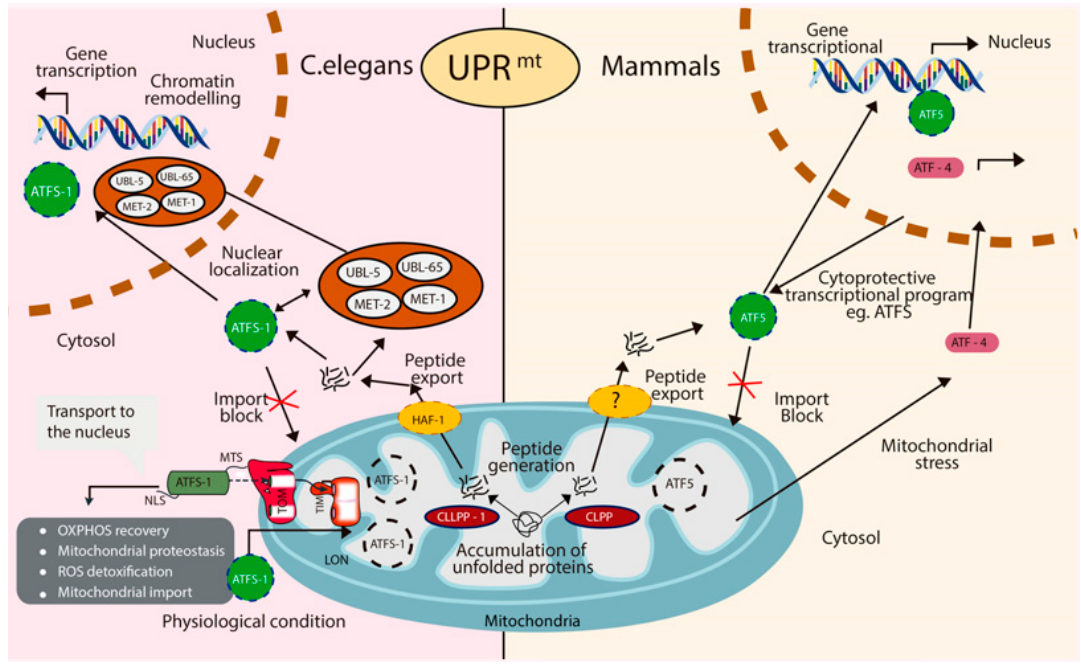
Figure 3. Mitochondria unfolded protein response (UPRmt). In both, mammals and C. elegans, activation of the UPRmt is caused by accumulation of unfolded proteins inside of the mitochondria matrix. Proteolysis of impaired proteins is carried by the effects of the ClpP protease. In C. elegans, export of these peptides to the cytosol is accomplished by HAF-1 which activates ATFS-1 (in C. elegans) or ATF5 (in mammals) to allow nuclear translocation and initiate transcription of this pathway genes. Physiologically, to prevent unnecessary activation of this signaling, ATFS-1 is imported into the mitochondria via the mitochondrial-targeting-sequence (MTS), formed by the translocase of the outer membrane (TOM) and the translocase of the inner membrane (TIM) to allow degradation of ATFS-1 by the protease LON. Furthermore, in C. elegans, translocation to the nucleus of the proteins UBL-5, LIN-65, MET-1 and MET-2 upon UPRmt activation facilitates the binding of ATFS-1 by chromatin remodeling. Ultimately, activation of ATFS-1 and ATF5 induces genes to promote OXPHOS recovery, ROS detoxification, expression of mitochondrial protein import components and upregulation of chaperones and proteases to re-establish mitochondria